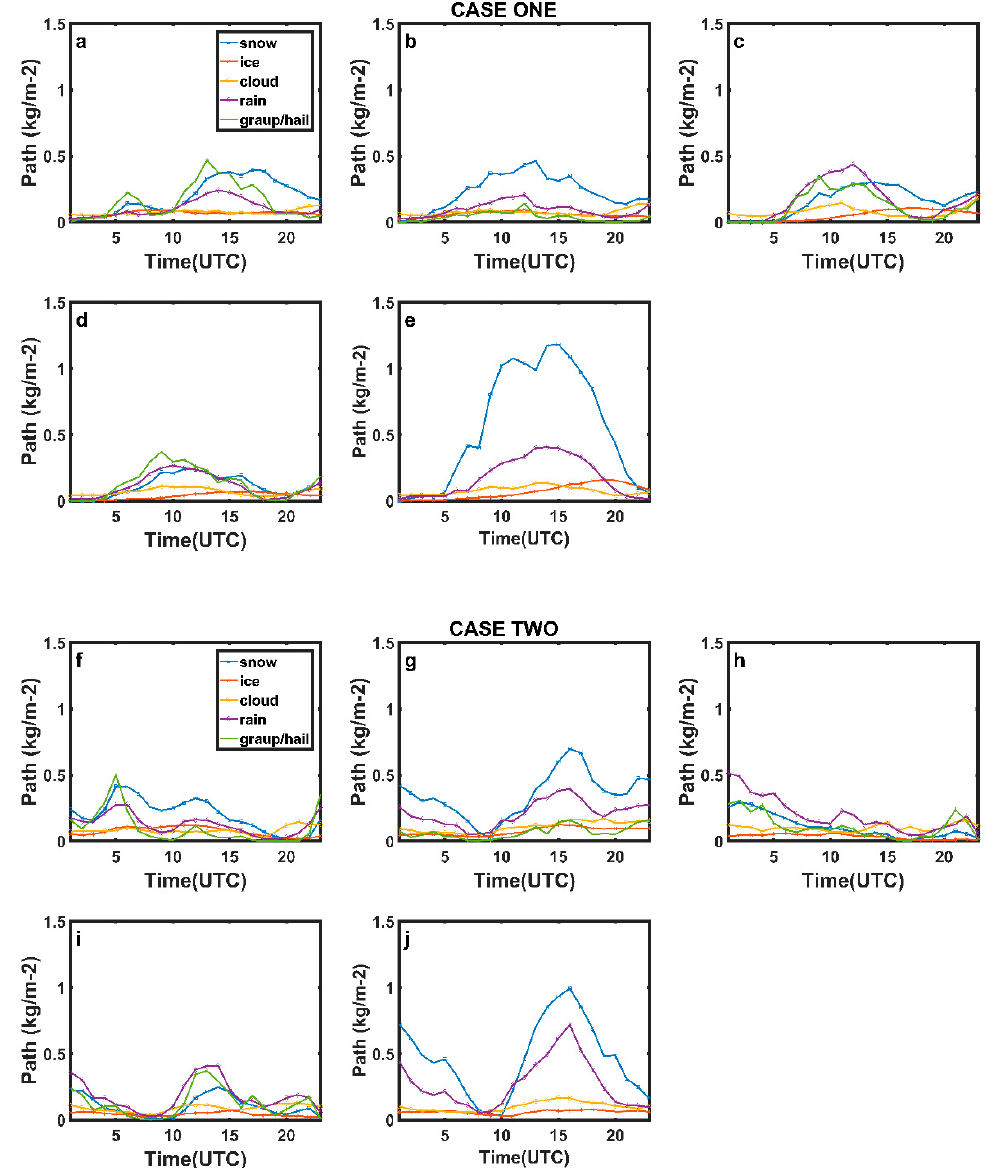
Figure 5. Time series of area–averaged (5 ◦ N–9 ◦ E, 4 ◦ N–6 ◦ N) hydrometeors paths of all the schemes used and their cloud hydrometeors CASE ONE ( a ) MORR_G ( b ) MORR_H ( c ) WDM6 ( d ) WSM6 and ( e ) WSM5 and CASE TWO ( f ) MORR_G ( g ) MORR_H ( h ) WDM6 ( i ) WSM6 and ( j )